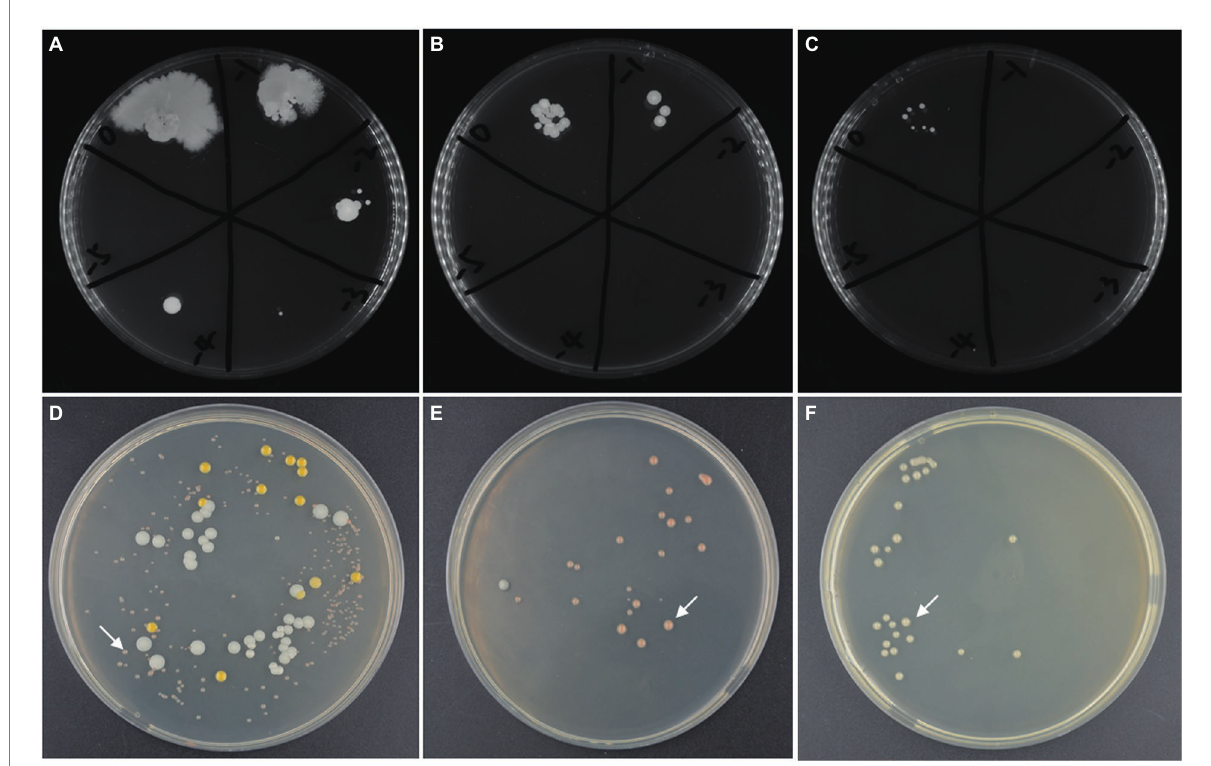
FIGURE 3 The microbial contamination in silkworm excrement medium with different salinity: (A) 10% NaCl; (B) 15% NaCl; (C) 20% NaCl and the microbial composition in open fermentation studied by CFU counting method after incubated for 168 h. (D) the fermented broths of the SE medium with 10% NaCl (72 h’ incubation); (E) the fermented broths of SE medium with 15% NaCl (120 h’ incubation); (F) the fermented broths of SE medium with 20% NaCl (120 h’ incubation). The target strain ATCC 33500 is indicated by white arrows (D–F)